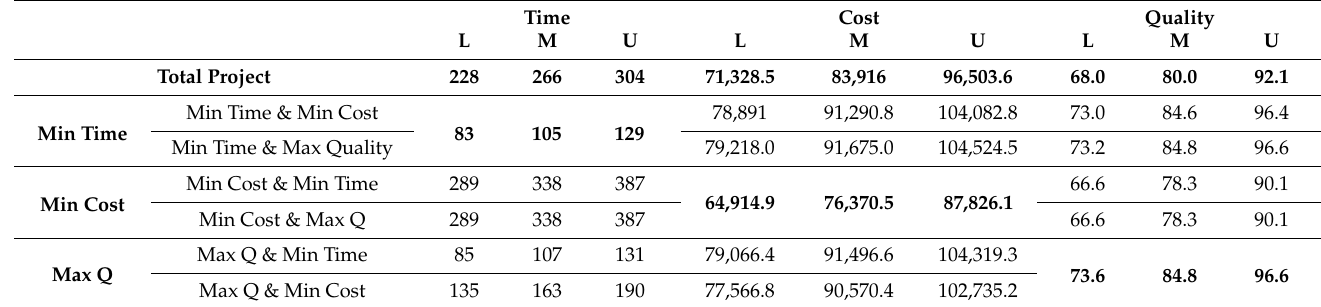
Table 9. Sensitivity analysis (project by 32